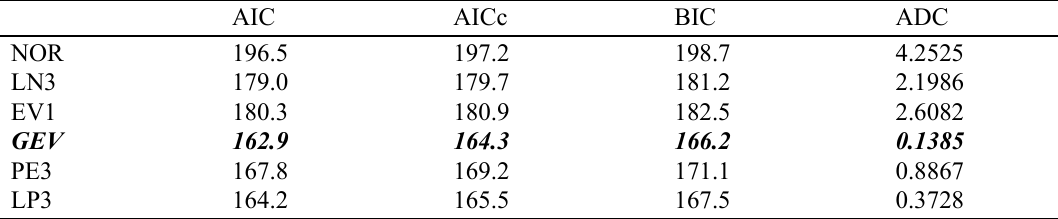
Table 1 Summary of goodness-of-fit tests.